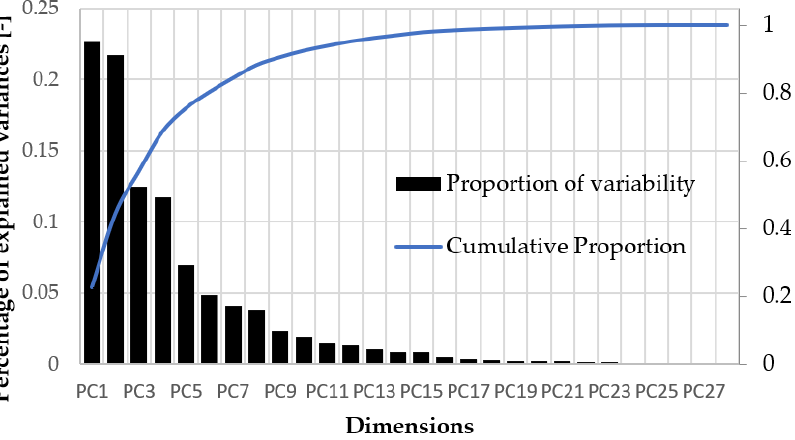
Figure 3. Percentage of explained variances with PCA, individual proportion (black) and cumulative (blue).